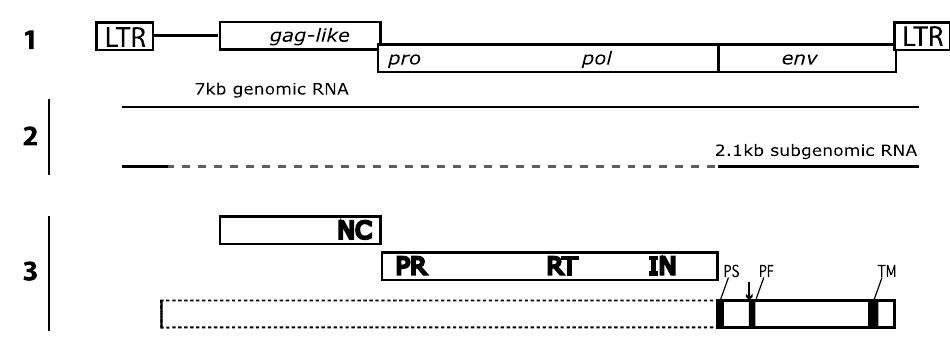
Figure 2. Structure of the gypsy proviral genome, mRNAs and proteins. 1- Proviral genetic map: LTR, Long Terminal Repeat. 2- Genomic RNA and spliced env subgenomic RNA. 3- Functional domains of Gag-like, Pro, Pol and Env polyproteins: NC, nucleocapsid; PR, protease; RT, Reverse Transcriptase; IN, Integrase; PS, peptide signal; PF, peptide fusion; TM, transmembrane; arrow indicates the furin cleavage